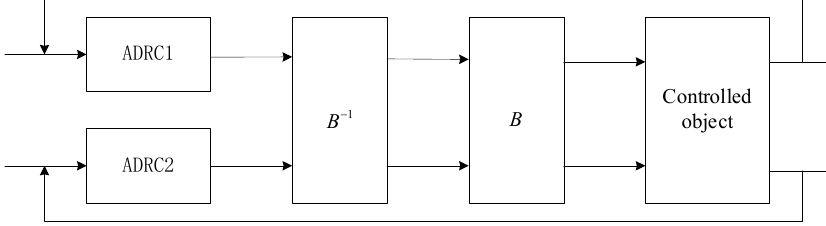
Fig. 3. Diagram of ADRC decoupling